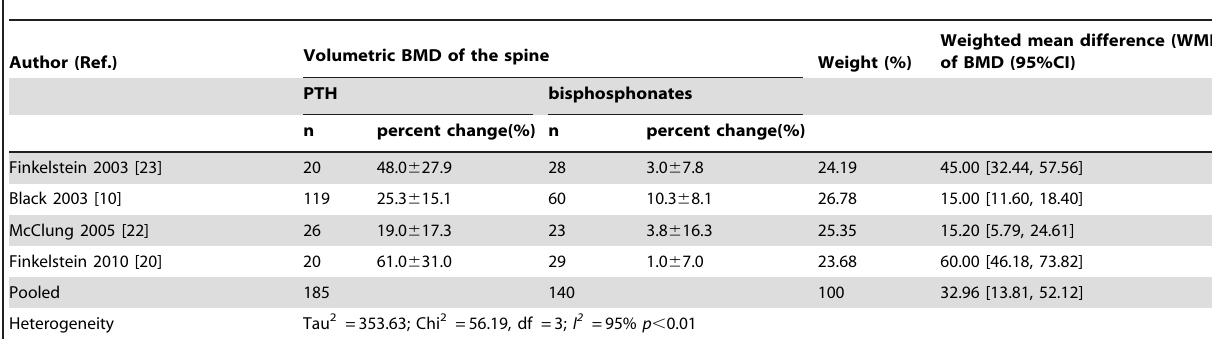
Table 2. Effects of PTH versus bisphosphonates on volumetric BMD of the spine.